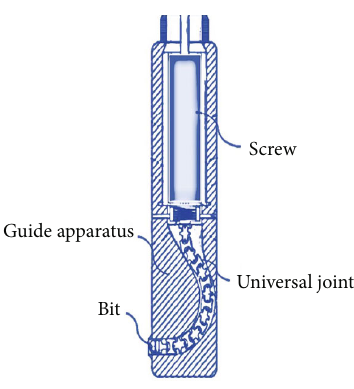
Figure 1: The casing window drilling tool assembly